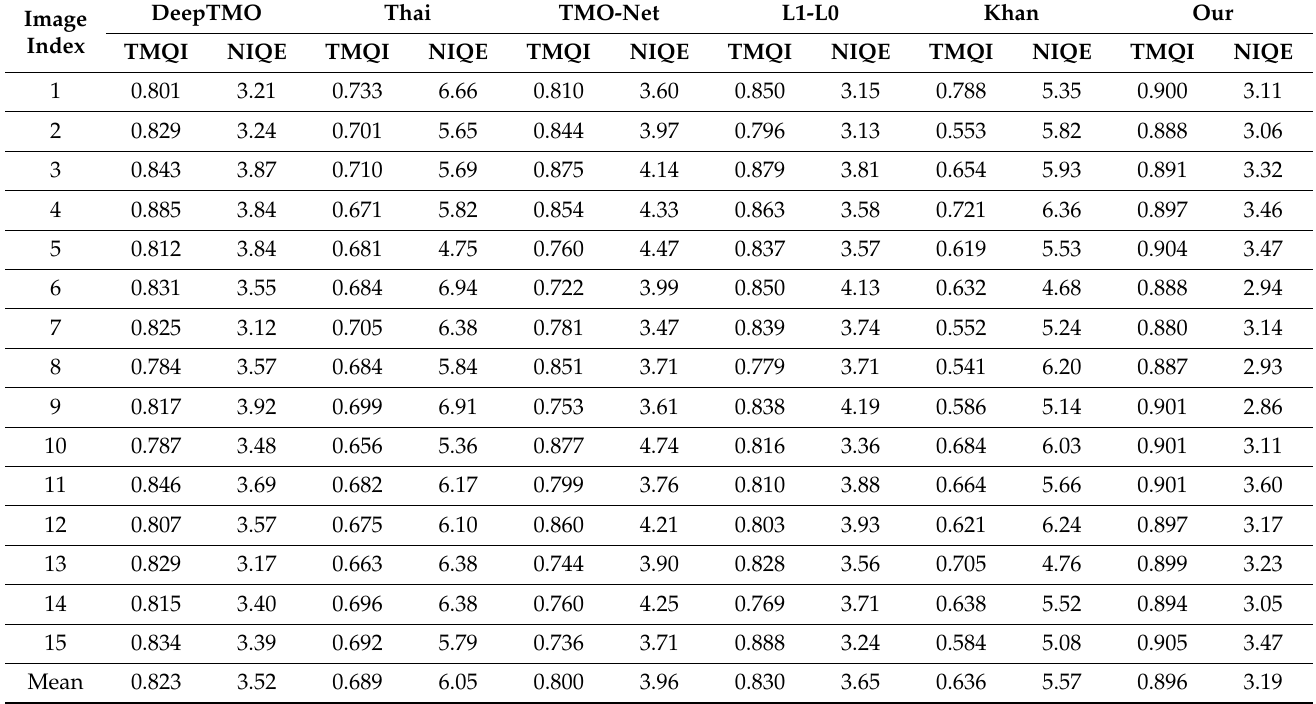
Table 2. Objective evaluations using 6 tone mapping algorithms and 15 radiance maps from the TMQI